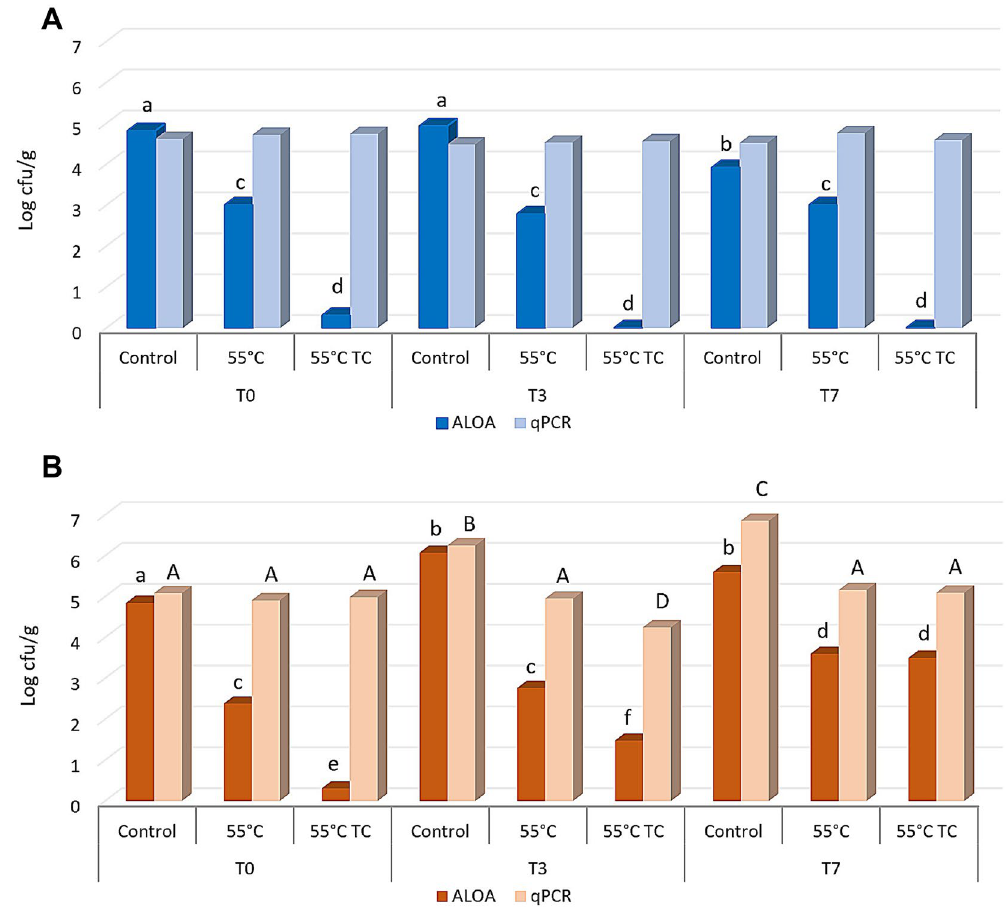
Figure 4. Culturability on ALOA and total L. monocytogenes cell counting by qPCR with species specific primer on roast beef slices ( A ) and Gorgonzola rind ( B ) stored at 4 °C after contamination. Before the inoculum cells were not treated (Control), treated at 55 °C (55 °C) or treated at 55 °C in the presence of thymol and carvacrol (55 °C TC). Significant differences between samples according to ANOVA are indicated by lowercase letters for cell culturability and capital letters for cell counting by